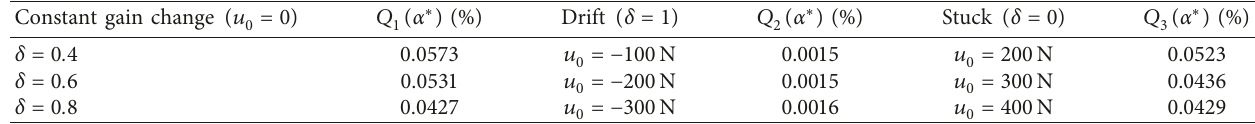
Table 5: Estimation results for different faults.